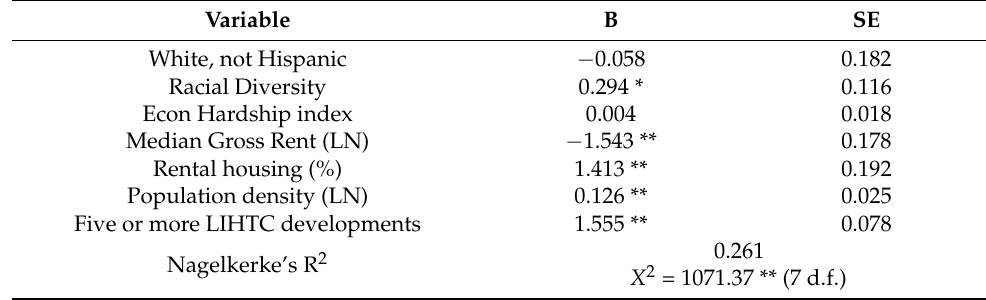
Table 8. Logistic regression: LIHTC Neighborhoods, California without Los Angeles County. Variable B SE White, not Hispanic − 0.058 0.182 Racial Diversity 0.294 * 0.116 Econ Hardship index 0.004 0.018 Median Gross Rent (LN) − 1.543 ** 0.178 Rental housing (%) 1.413 ** 0.192 Population density (LN) 0.126 ** 0.025 Five or more LIHTC developments 1.555 **